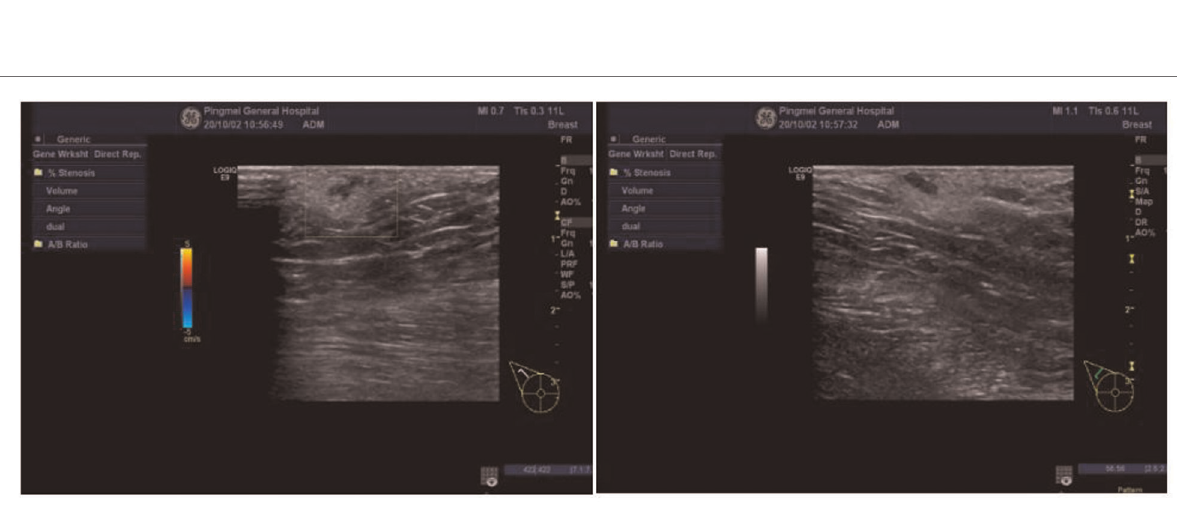
FIGURE 6 Ultrasound examination of the right armpit. An accessory breast was in the right armpit, at about 0.67 × 0.49 × 0.28 cm 3